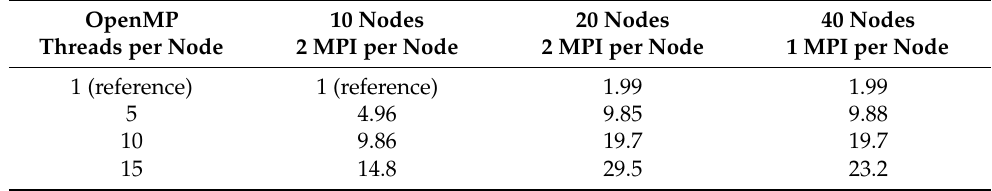
Table 3. Case study 1: speed-up values for task (c) with OpenMP–MPI on MARCONI Cluster.